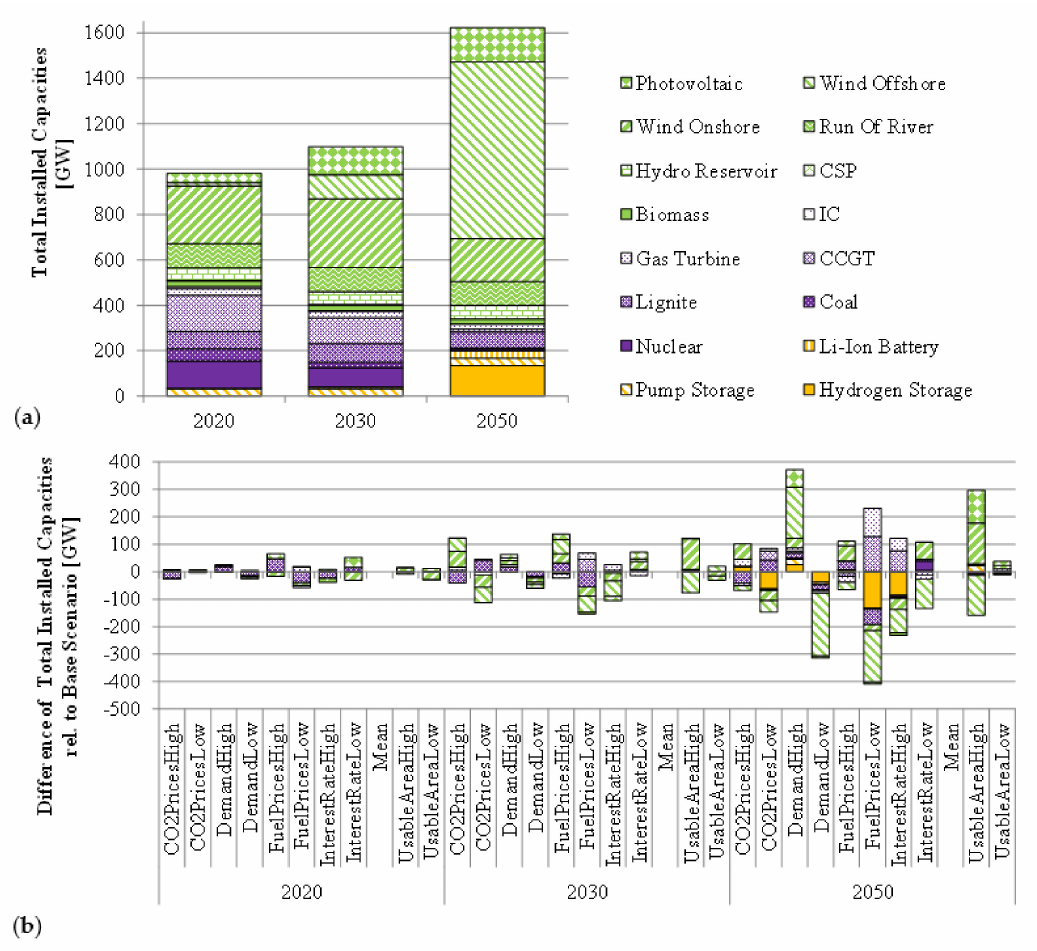
Figure 6. REMix-model-simulation results: ( a ) installed capacities; ( b ) sensitivity analysis, absolute